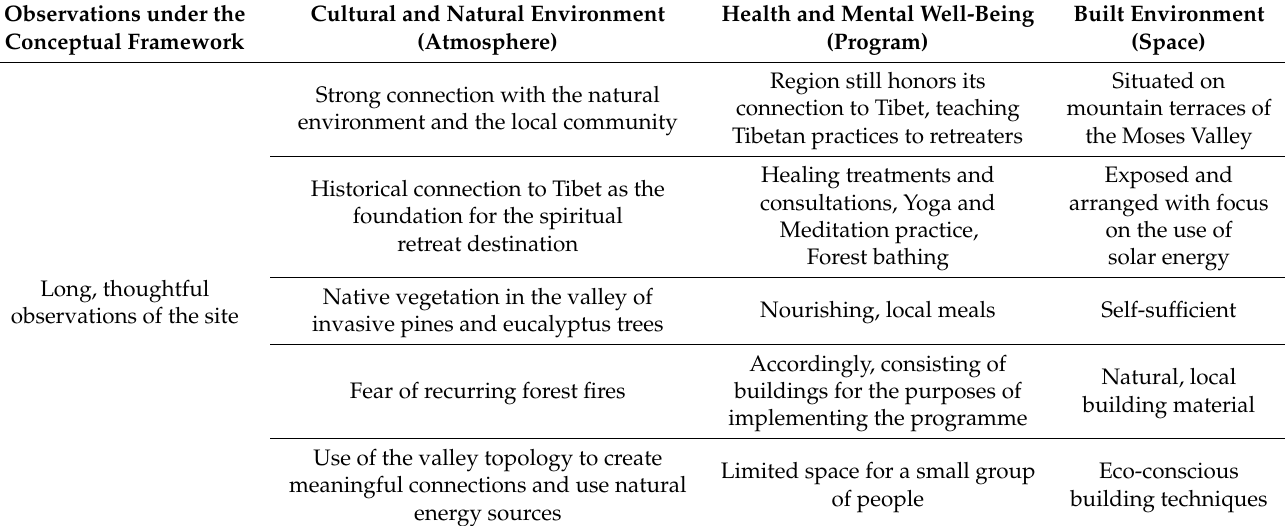
Table 1. Observations of the study area through the science of